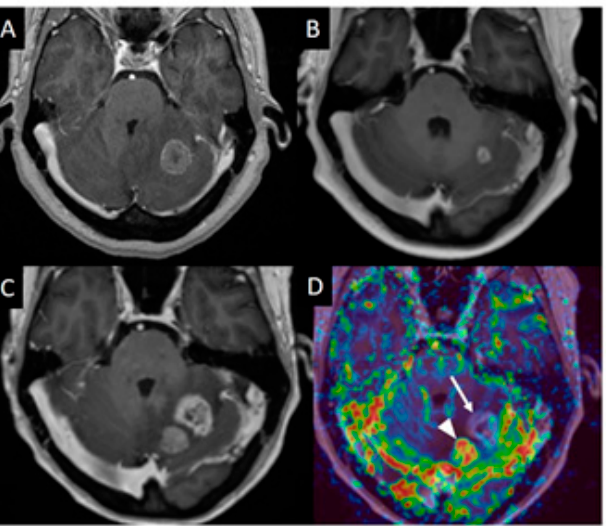
Figure 1. T1-weighted and DSC imaging of a left cerebellar metastasis. ( A ) Post contrast T1-Weighted MRI image of a 40 yo (year old) female with colon cancer and left cerebellar metastasis. ( B ) MRI 7 months later showed marked reduction is size after radiosurgery treatment. ( C ) MRI performed 11 months after treatment showed increase in size of the treated lesion and a new enhancing lesion medial to it. ( D ) CBV map from DSC perfusion (arrow) demonstrates mainly low perfusion. Some small foci of slightly elevated perfusion may represent foci of recurrent tumor on a background of predominant radiation necrosis.